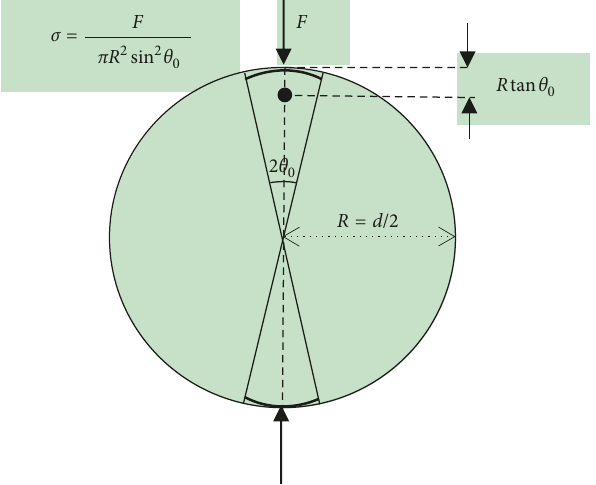
Figure 3: Force F acts normal to the sphere surface on an area defined by the angle θ 0